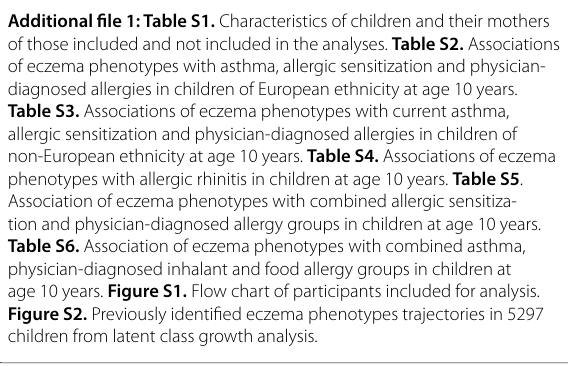
Table S6. Association of eczema phenotypes with combined asthma, physician-diagnosed inhalant and food allergy groups in children at age 10 years. Figure S1. Flow chart of participants included for analysis. Figure S2. Previously identified eczema phenotypes trajectories in 5297 children from latent class growth